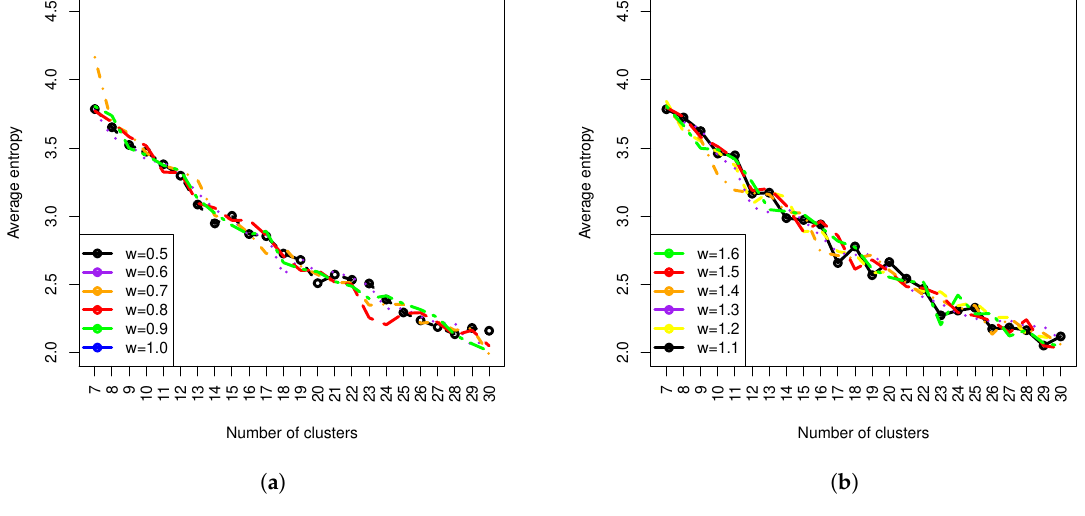
Figure 5. The results of the average entropy weighted by exposures of each cluster for different weighted clusterings by taking different values of w 1 . ( a ) is the result corresponding to w 1 = 0.5, 0.6, 0.7, 0.8, 0.9 and 1.0, respectively, and ( b ) is the result corresponding to w 1 = 1.1, 1.2, 1.3, 1.4,1.5 and 1.6, respectively. All loss cost data were used for this analysis and average loss cost weighted by